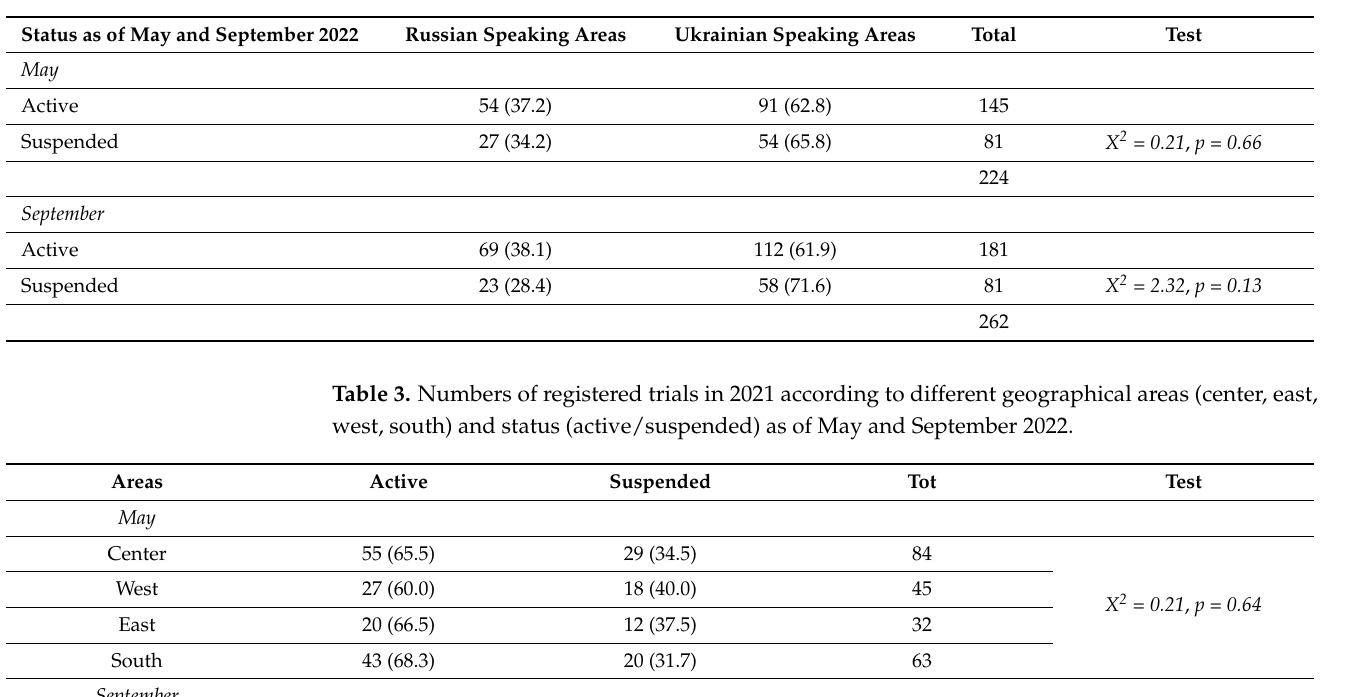
Table 2. Numbers of registered trials in 2021 according to different speaking areas and status (active/suspended) as of May and September 2022.